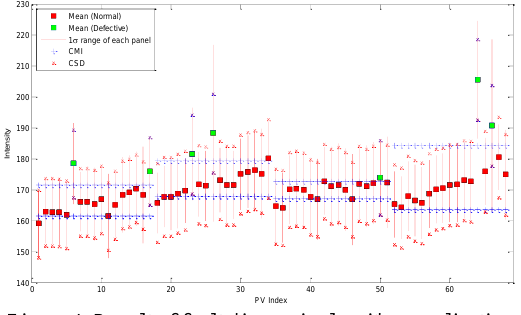
Figure 4. Result of fault diagnosis algorithm application We performed additional algorithm implementation on two